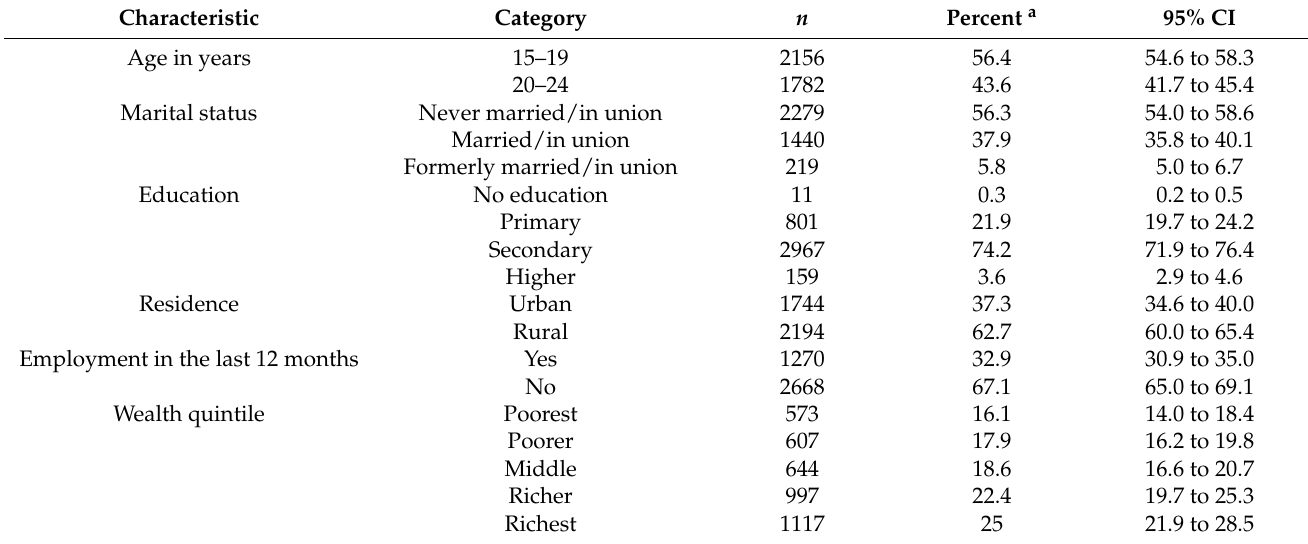
Table 1. Socio-demographic characteristics of AGYW in Zimbabwe DHS